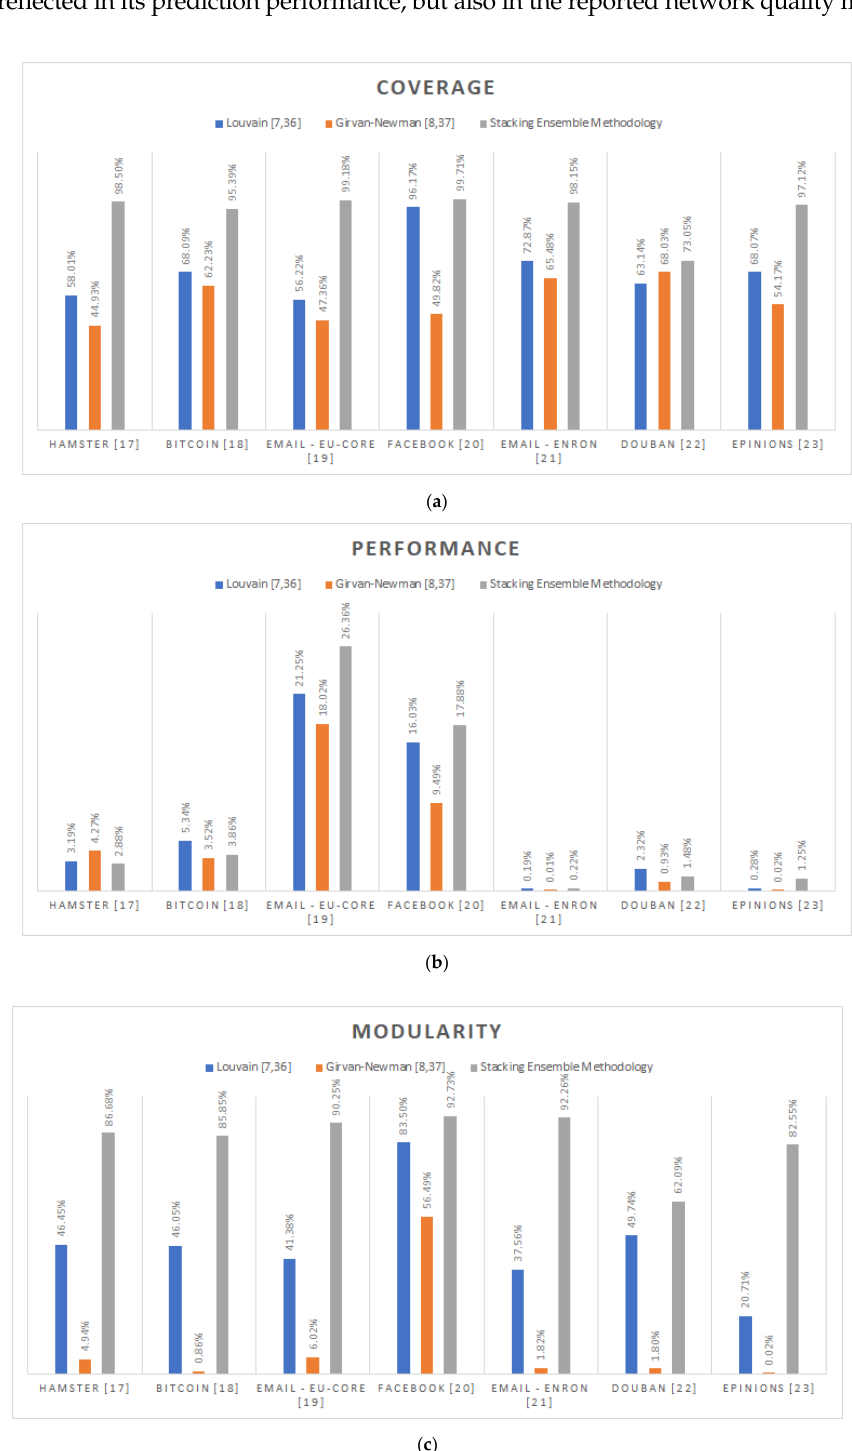
Figure 4. Network analysis comparison of the proposed stacking methodology against the Louvain [7,36] and the Girvan-Newman [8,37] community detection algorithms: ( a ) Coverage; ( b ) Performance; ( c ) Modularity. The extraction of more discernible community structures is also cross-validated by the modularity measure, which is broadly considered [1–3] as one of the most indicative quality functions. Taking into account that a null model is a randomized version of the original graph which preserves the input graph’s degree sequence, modularity practically quantifies the difference between the generated hierarchy’s average coverage and the cor- responding of the standard null model. As well explained in [1], the higher the calculated modularity, the denser and thus more discernible the extracted community hierarchy will be. Hence, by reporting 84.63% in average modularity, the proposed stacking prediction methodology manages to detect consistently denser community hierarchies comparing to the Louvain [7,36] and the Girvan–Newman [8,37] algorithms by 38.15% and 74.35% in average, respectively. The significance of this conclusion is further strengthened consid- ering that the Louvain [7,36] algorithm’s primary intention is to maximize the modularity of the generated structure. Regarding the performance network quality measure, the root cause of the calculated mediocre overall results lays on the sparsely connected input graphs. By definition, the performance aims to calculate the ratio of the vertices’ pairs that either belong to the same community and are connected, or do not belong to the same community and are not con- nected, to all possible pair of vertices. As a result, the sparser the original graph, the lesser the impact of the community extraction to this corresponding quality measure. Hence, considering the “Average Degree” column of Table 1, only the Email-Eu-Core [19] and Facebook [20] graphs might be eligible for consideration. For this cases, the proposed stacking ensemble methodology outreaches, in average, the Louvain [7,36] algorithm’s performance by 3.48% and the corresponding of the Girvan–Newman [8,37] by 8.37%. Finally, it should be strongly noted that the Louvain algorithm’s close imitation of the proposed stacking ensemble methodology, with regard to the Facebook graph [20], is not only reflected in its prediction performance, but also in the reported network quality metrics. 4.3. Execution Performance Evaluation In terms of completeness, despite the fact that the execution performance comparison between the classic community detection algorithms and a fully distributed, near-linear